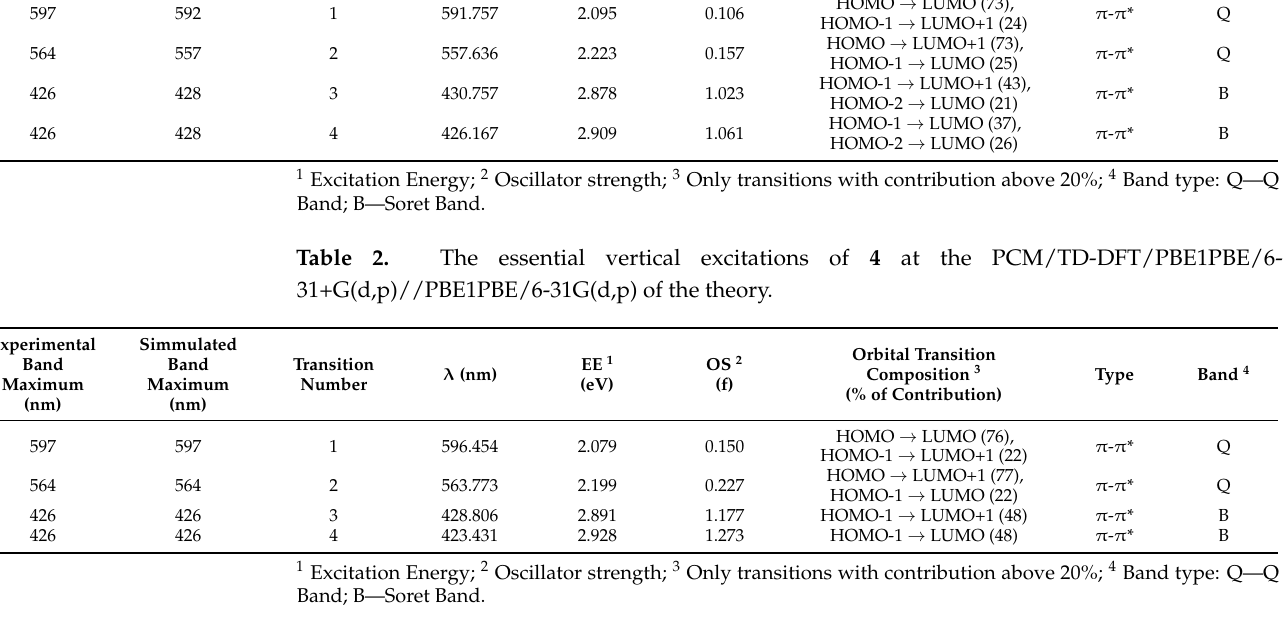
The essential vertical excitations of 5 at the PCM/TD-DFT/PBE1PBE/6-